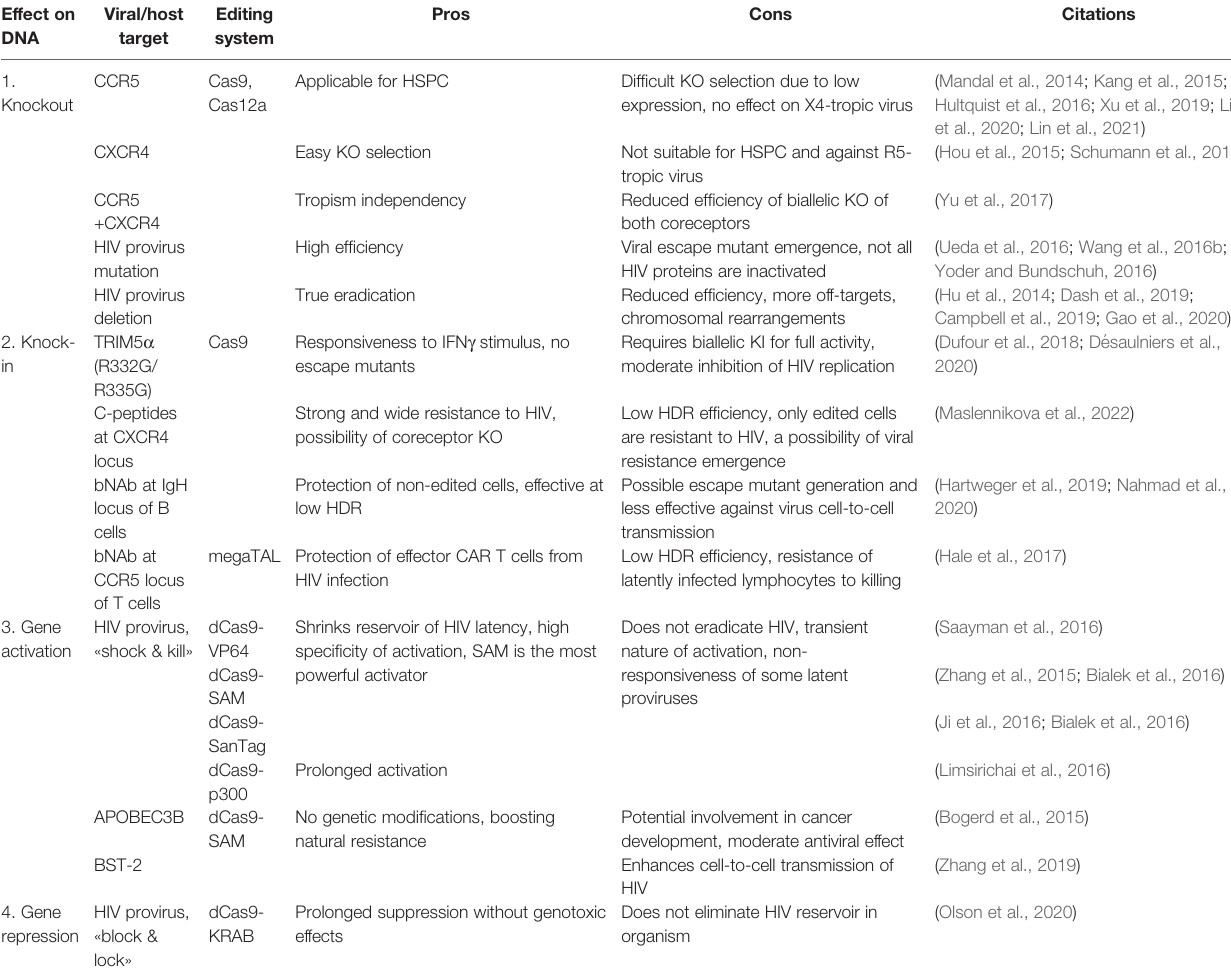
TABLE 1 | Pros and cons of different anti-HIV CRISPR/Cas